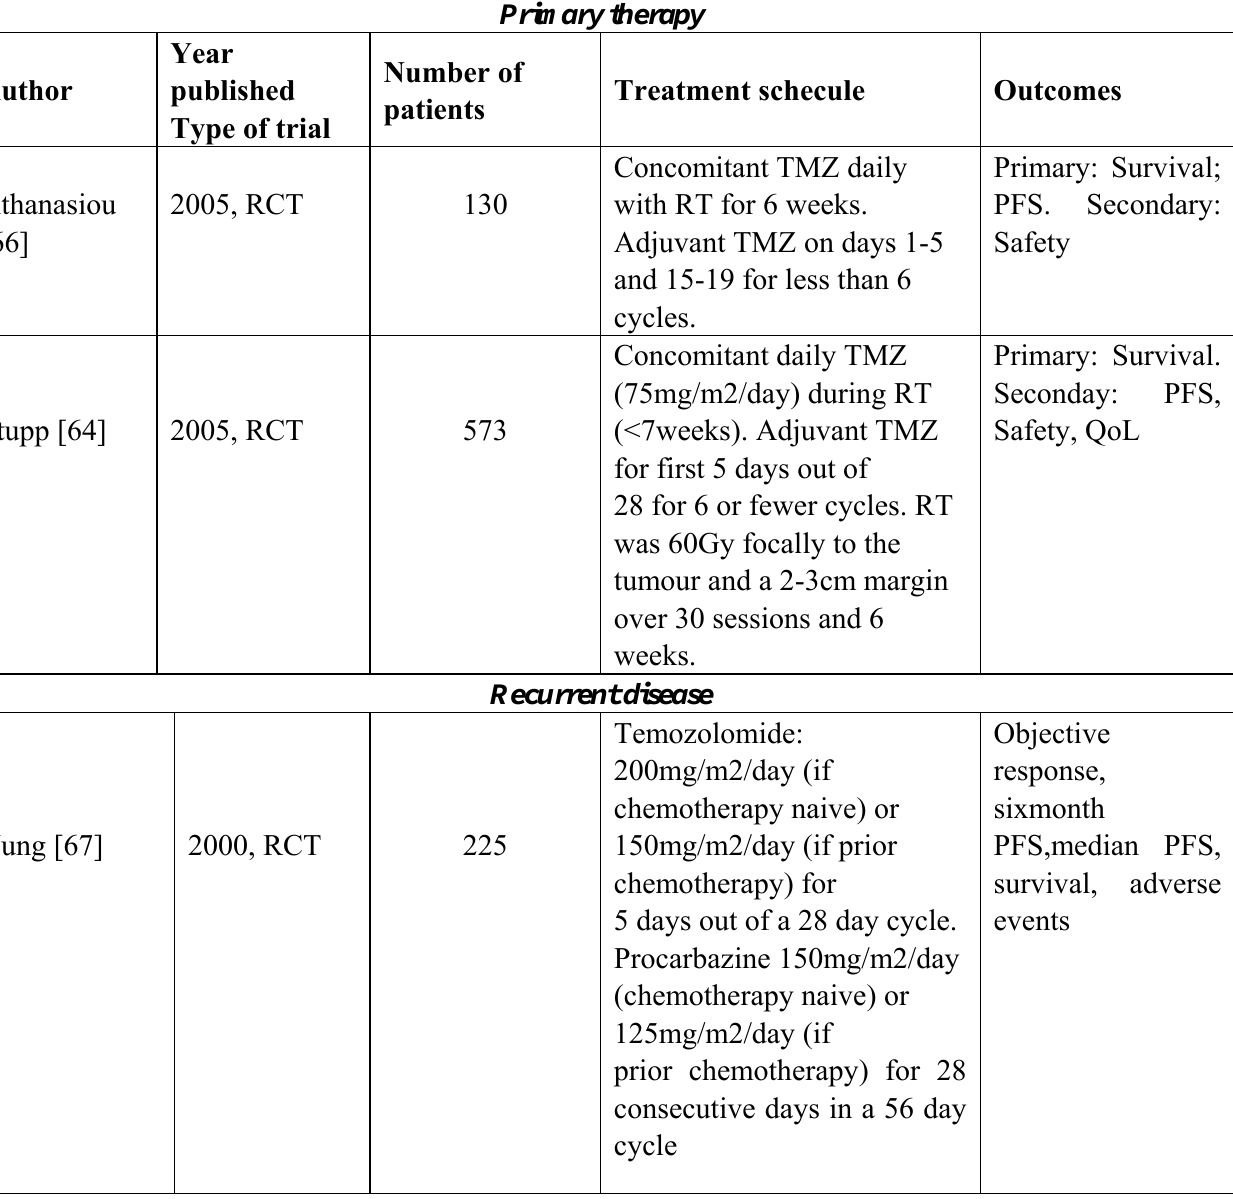
Table 2 . Characteristics of eligible